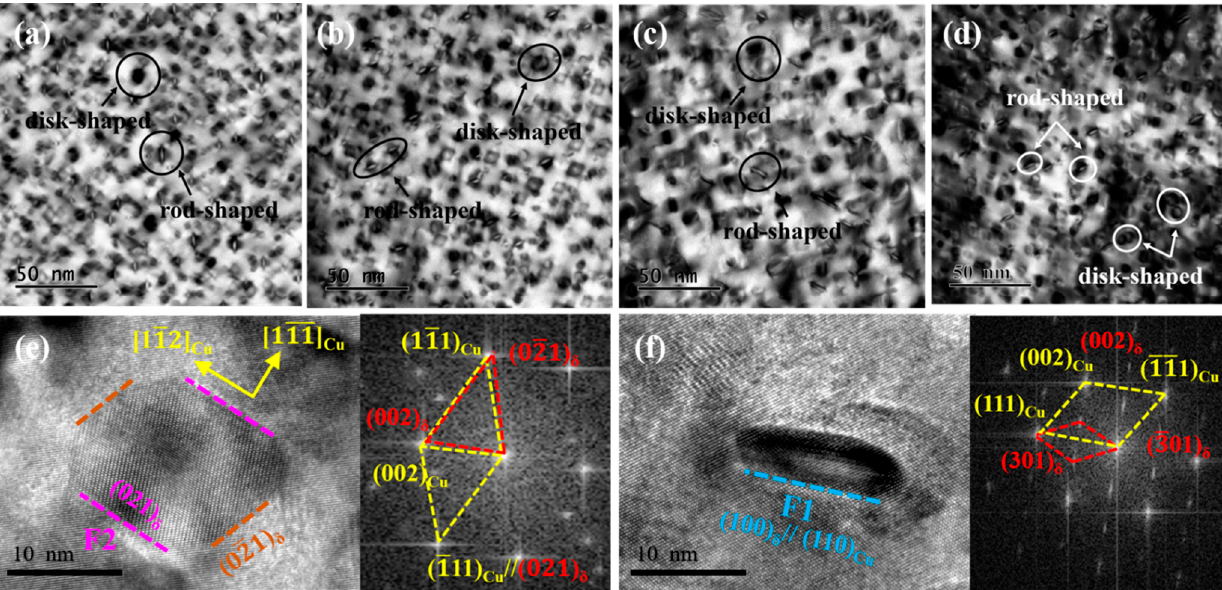
Figure 6. TEM and HRTEM images of the tested alloys at the peak aging state. ( a – d ) Bright-field of [110] Cu ; ( e ) HRTEM image corresponding to the disk precipitate; ( f ) HRTEM image corresponding to the rod precipitate.